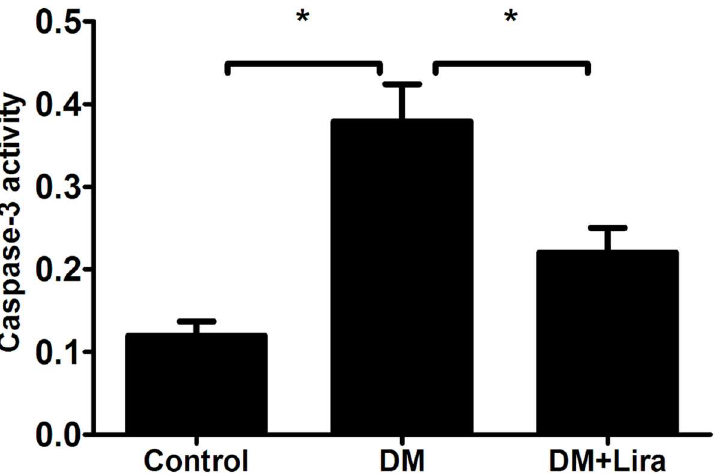
Fig 3. Caspase-3 activity was compared among the control group (A), DM group (B), and DM + liraglutide group (C) (n = 5, * p < 0.05). Caspase-3activity was decreasedby 43.6% in the DM + liraglutide group comparedwith the DM group. Diabeticrats were dividedinto two groups, administered without (DM group) or with liraglutide(DM + Lira group) at a dose of 200 μ g/kg/d. SD rats of control group were fed with normalchew and received subcutaneous injectionof saline(DM group: 0.39 ± 0.10 vs. DM + liraglutidegroup: 0.22 ± 0.07) (p < 0.05).